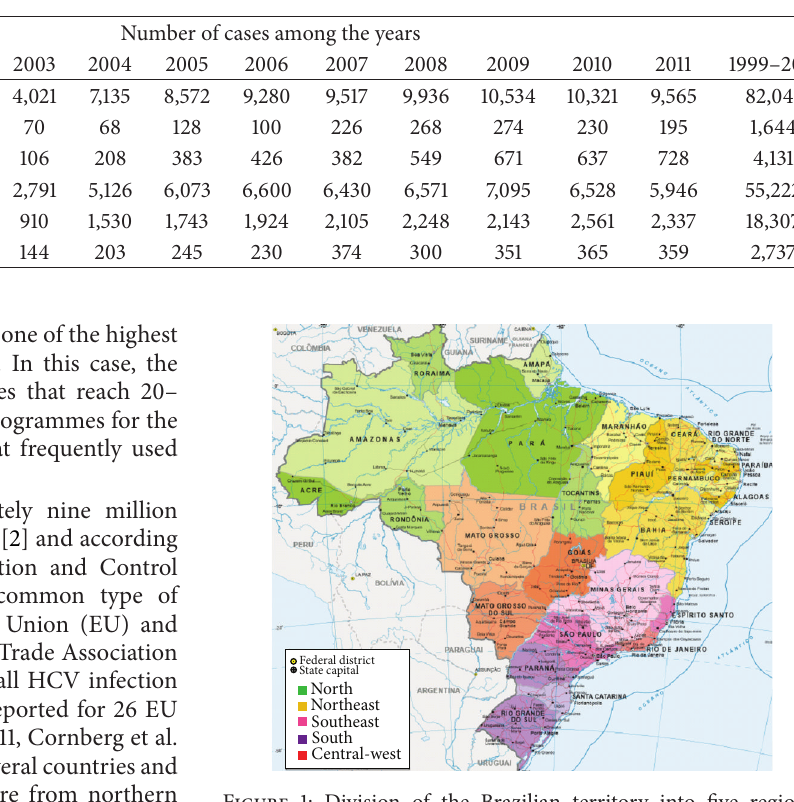
Figure 1: Division of the Brazilian territory into five regional geographic areas